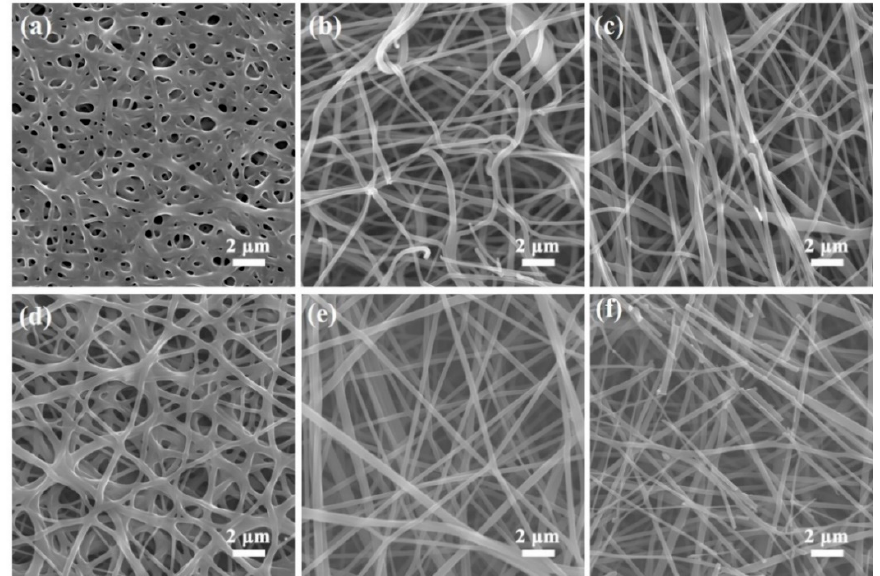
Figure 3. Scanning electron microscopy ( SEM) images of PAN-derived carbon nanofiber mats of ( a ) C-1, ( b ) C-2, ( c ) C-3, and ( d ) C-4; SEM images of PAN-derived carbon nanofibers of ( e ) C-5 and ( f ) C-6.